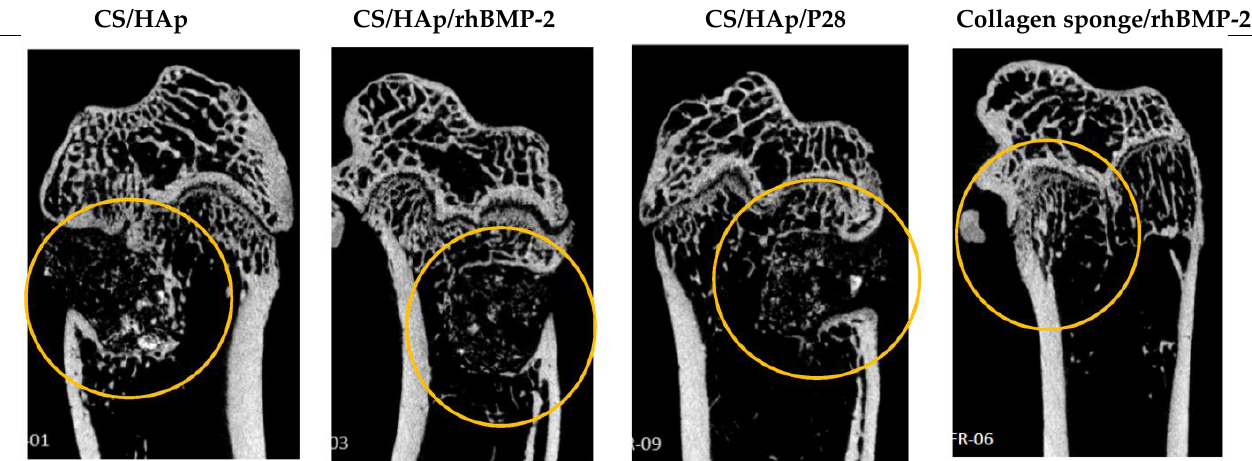
Figure 8. Representative coronal view images of the femoral condyle in CT scan per sample group after eight weeks of implantation. The condyle implanted with collagen sponge/rhBMP-2 is observed to reach the terminal healing process while traces of scaffolds were still present in CS/HAp scaffolds. However, CS/HAp/P28 gave better defect closure compared to CS/HAp and CS/HAp/rhBMP-2. (Annotation: Yellow circle = Implantation site).